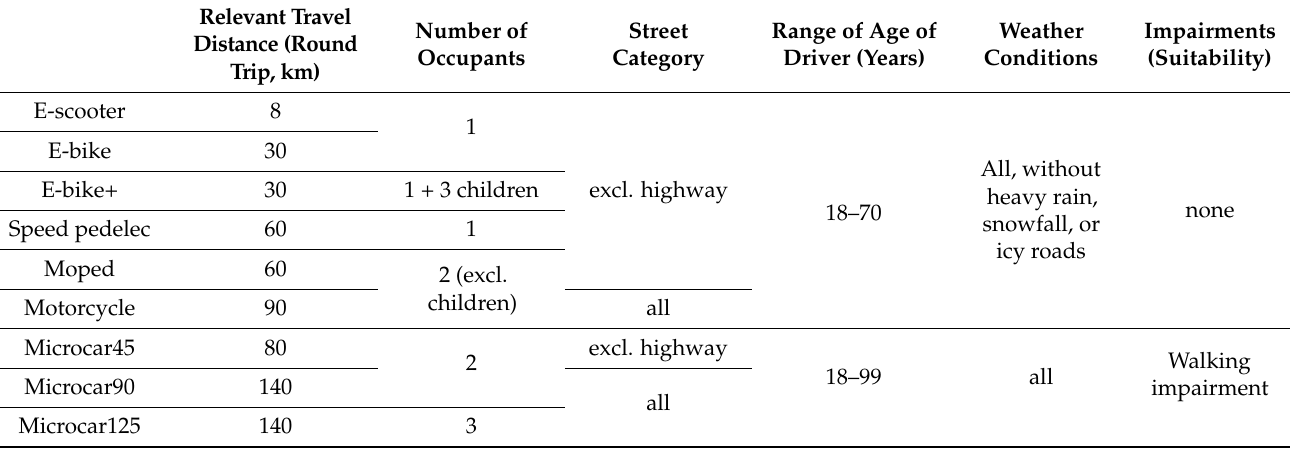
Table 2. Trips substitution criteria (see